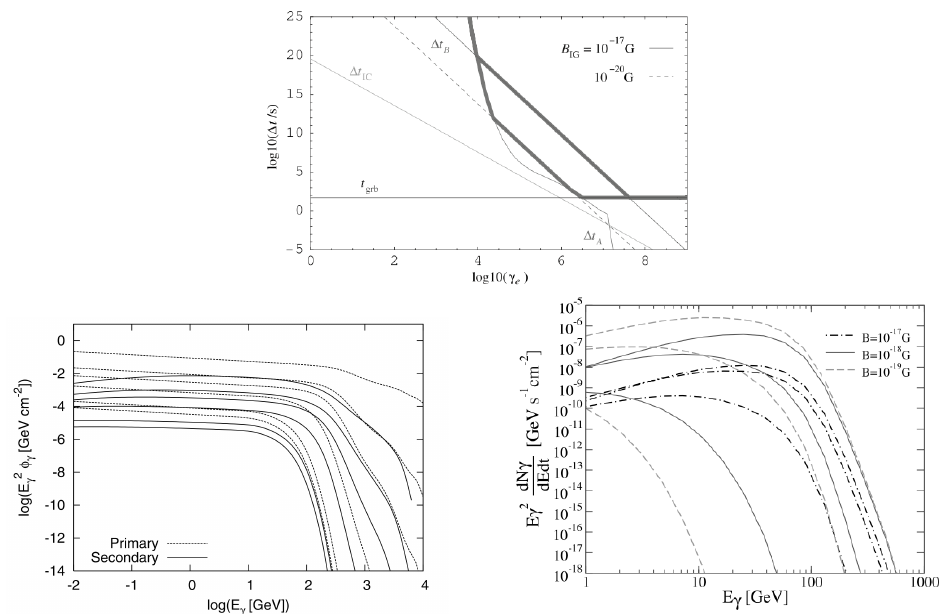
Figure 1. ( Top ) Different timescales (thin solid lines) over which the pair echo signal can be tem- porally smeared, shown for VHE γ -ray photons produced during the prompt emission over a duration t grb . Other timescales are the angular time due to IC cooling ( ∆ t IC ) and deflection of the produced pairs by the IGMF ( ∆ t B ; shown for two different IGMF magnetic field strengths) and the angular time associated to the mean free path over which the VHE γ -ray photons produce pairs ( ∆ t A ). The thick solid line highlights the dominant timescale for a given particle Lorentz factor γ e (cid:39) 1.25 × 10 6 ( E echo /GeV ) 1/2 ⇔ E echo (cid:39) 0.64 γ 2 GeV. Figure from [71] (©AAS. Reproduced with e ,6 permission.). ( Bottom-left ) The (observed) model primary and secondary (pair-echo) VHE γ -ray (cid:82) F γ dt , for flux density F γ ) from GRBs at different redshifts (top to bot- spectral fluences ( E γ φ γ = tom): z = { 0.1,0.3,0.5,1,3,5 } . The intrinsic primary spectrum is assumed to be a broken power-law: dN γ / dE γ ∝ ( E γ / E b γ ) − α for E sa γ < E γ < E b γ and dN γ / dE γ ∝ ( E γ / E b γ ) − β for E b γ < E γ < E max γ , where E sa γ is the synchrotron self-absorption break energy, E b γ is the peak photon energy and E max γ is the in- trinsic high-energy cutoff. The intrinsic spectrum in the figure assumes α = 1, β = 2.2, E b γ = 300keV, and E max γ = 10TeV. Figure from [73] (©AAS. Reproduced with permission.). ( Bottom-right ) The observed pair-echo spectrum shown for different IGMF strengths (with coherence length scale r IGMF = 100pc) and at different times ( t obs = 10 2 s, 10 4 s, 10 6 s) for a source at a fixed redshift of z = 1. The primary prompt emission spectrum is assumed to be a power-law with photon index β = 2.2 above the peak energy E b γ = 500keV with a cut-off energy of E max γ = 10TeV, where the prompt GRB has a duration of t GRB = 50s and luminosity L γ ,iso = 10 53 ergs − 1 . Figure from [74] (©AAS. Reproduced with